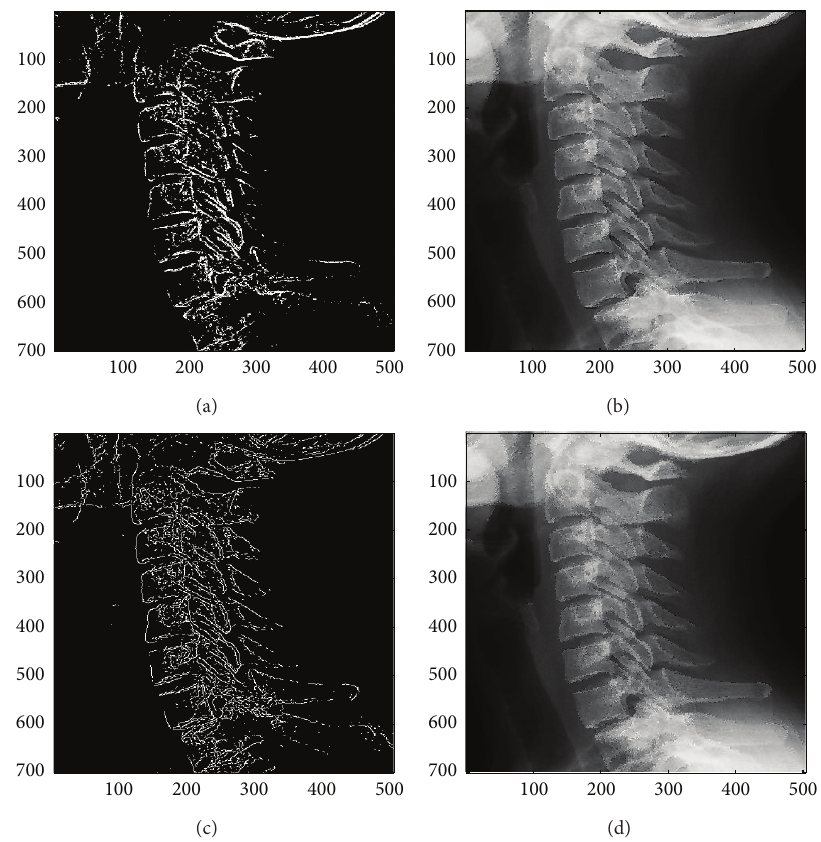
= 8 in the image “Neck.” (b) Result by HVD with scaling factor 𝑠 = 1.0 . (c) Edges detected by Figure 5: (a) Edges detected by HVD with 𝜃 eth Canny operator in the image “Neck.” (d) Result by Canny operator with scaling factor 𝑠 = 1.0 .